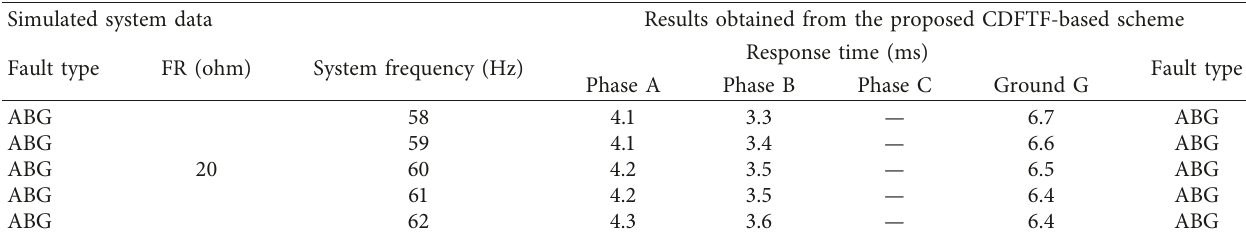
0 ° , FR 50 , and % Xc 60%: (a) 3-phase voltage waveform; (b) 3-phase current (cid:31) (cid:31) (cid:31) Ω 0 ° and FL 170km). (cid:31) (cid:31)